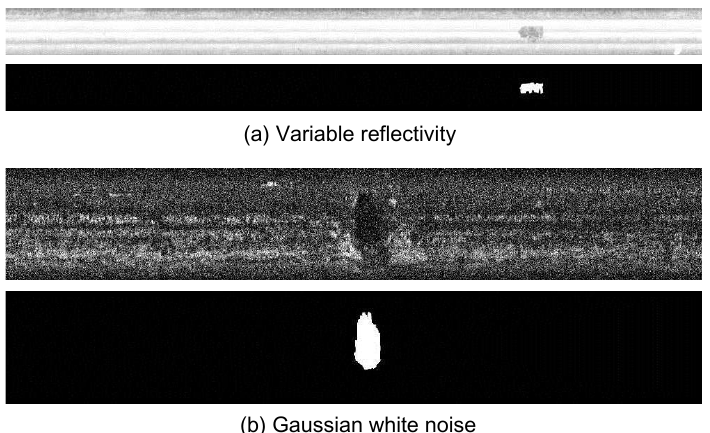
Figure 5. Robustness validation. Inspection results for example rails with ( a ) variable reflectivity and ( b ) Gaussian white noise with σ =